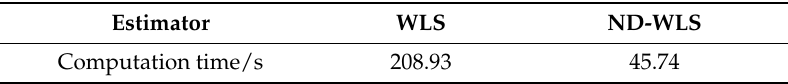
Figure 10. Estimated height of reliable SPSs and height difference histogram. ( a ) Estimated height of SPSs in the original largest connected network by ND-WLS estimator; ( b ) estimated height of SPSs in the expanded largest connected network by ND-WLS estimator; ( c ) the histogram of height difference between the height retrieved by ND-WLS estimator and WLS estimator. Table 3. Computation time by WLS and